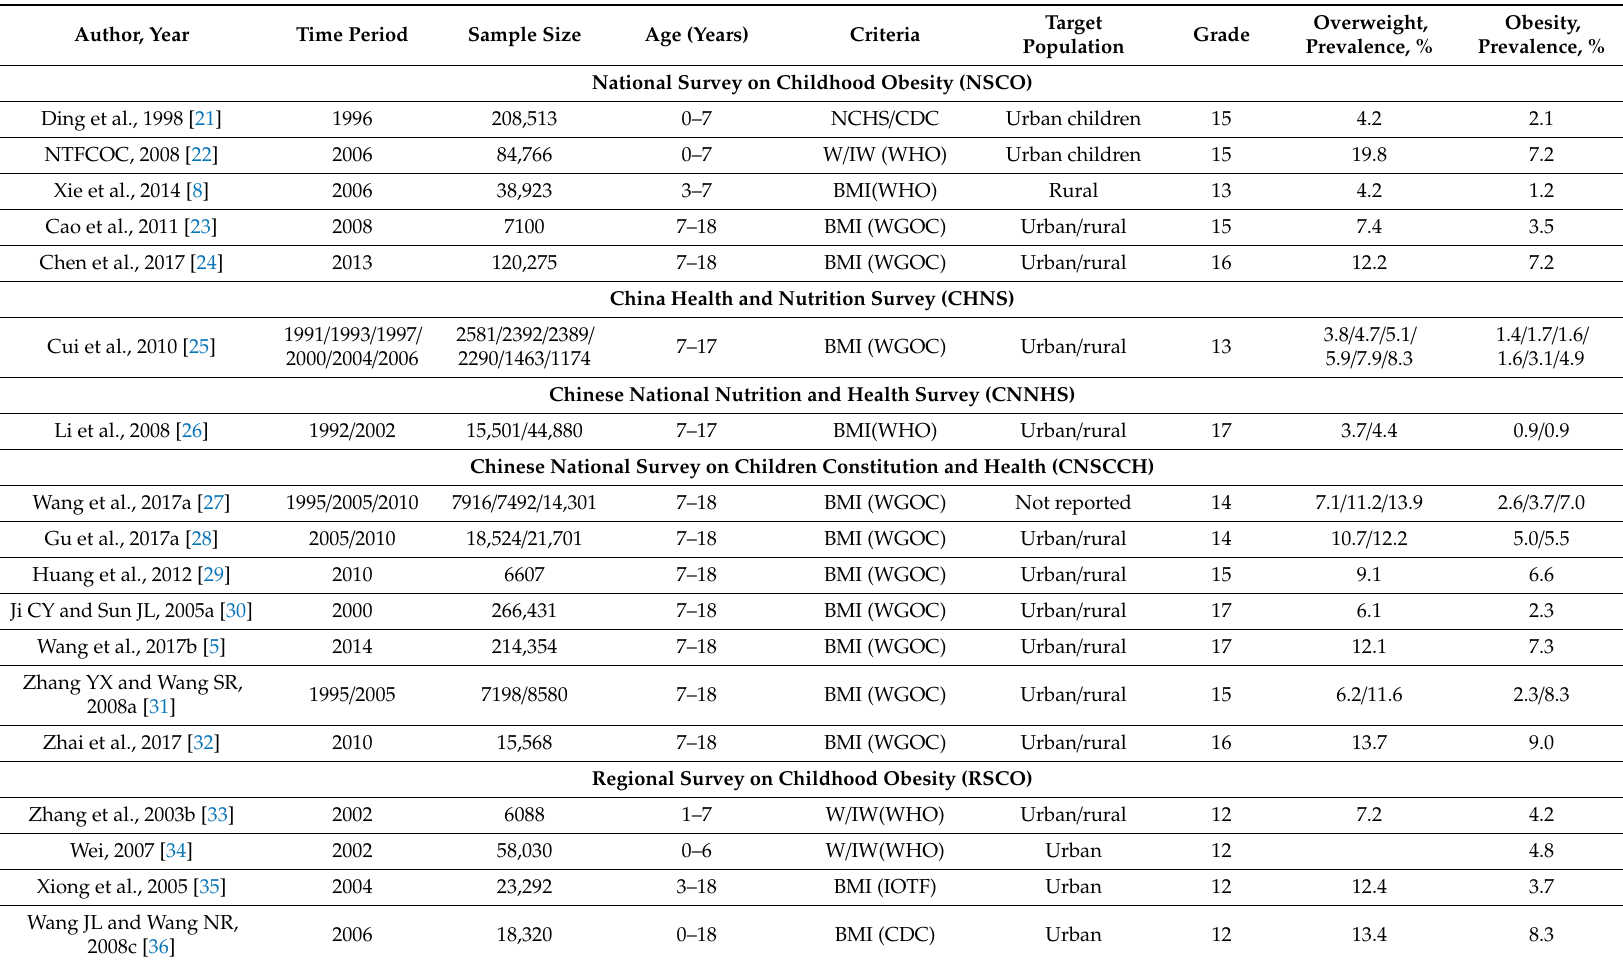
Table 1. General information and quality ratings included in the literature from 1991 to